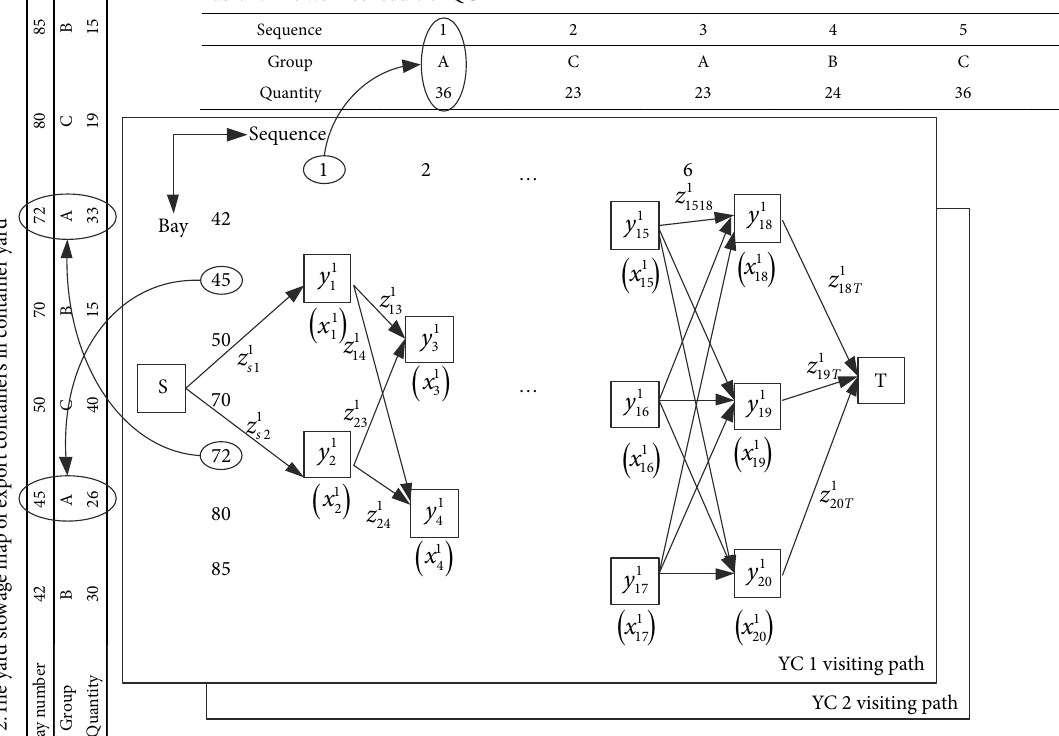
Table 1. e work schedule of QC A